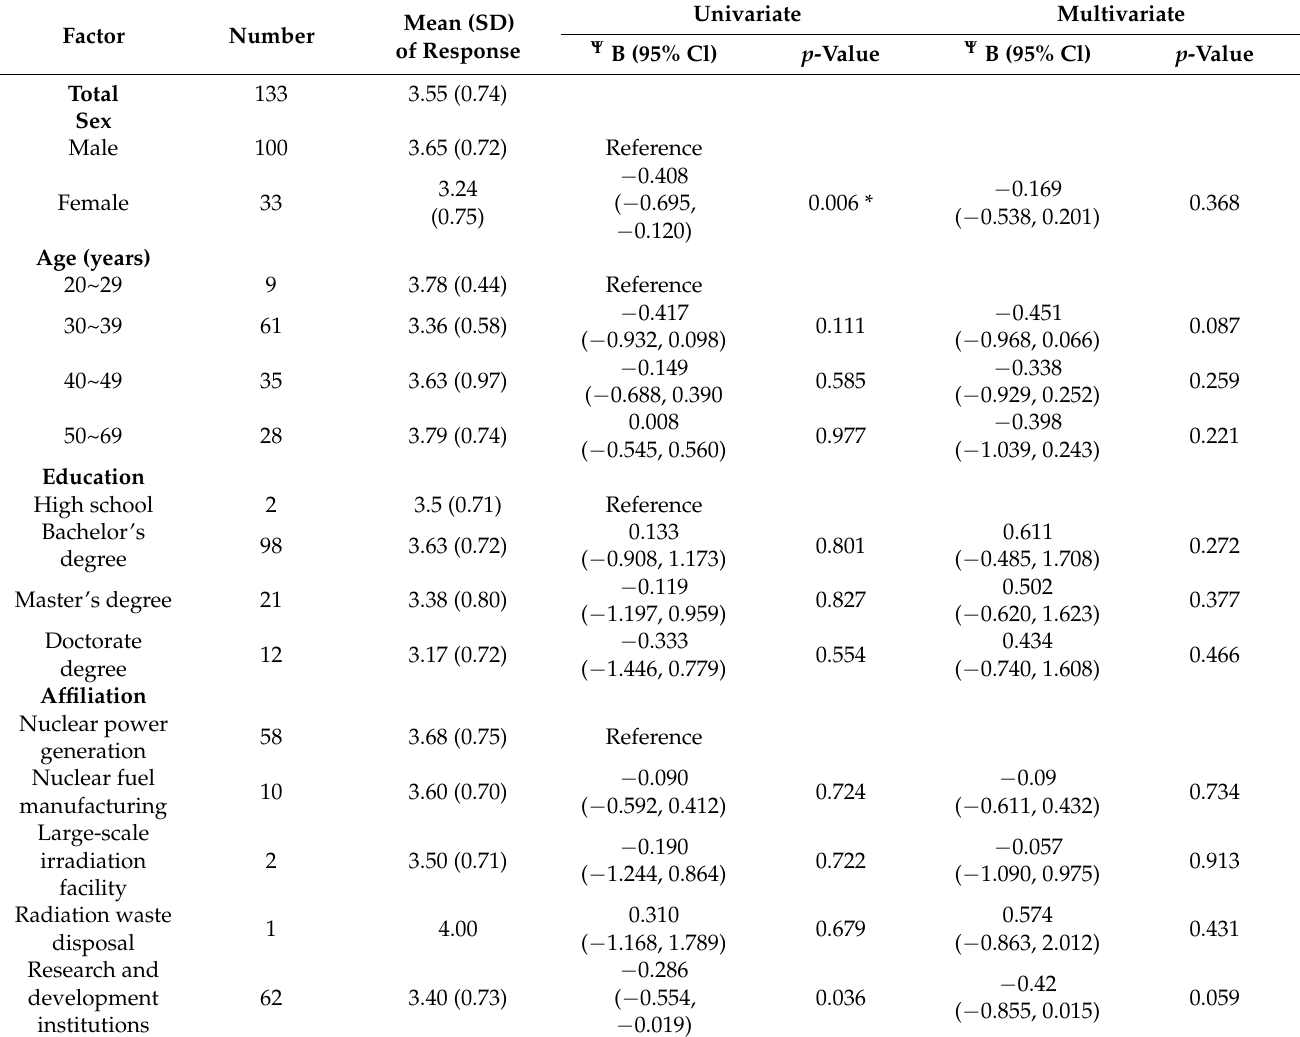
Table 2. Linear regression analyses of the factors associated with responses to the question, “Do you agree that the national plan of emergency medicine is well-prepared for nuclear or radiation